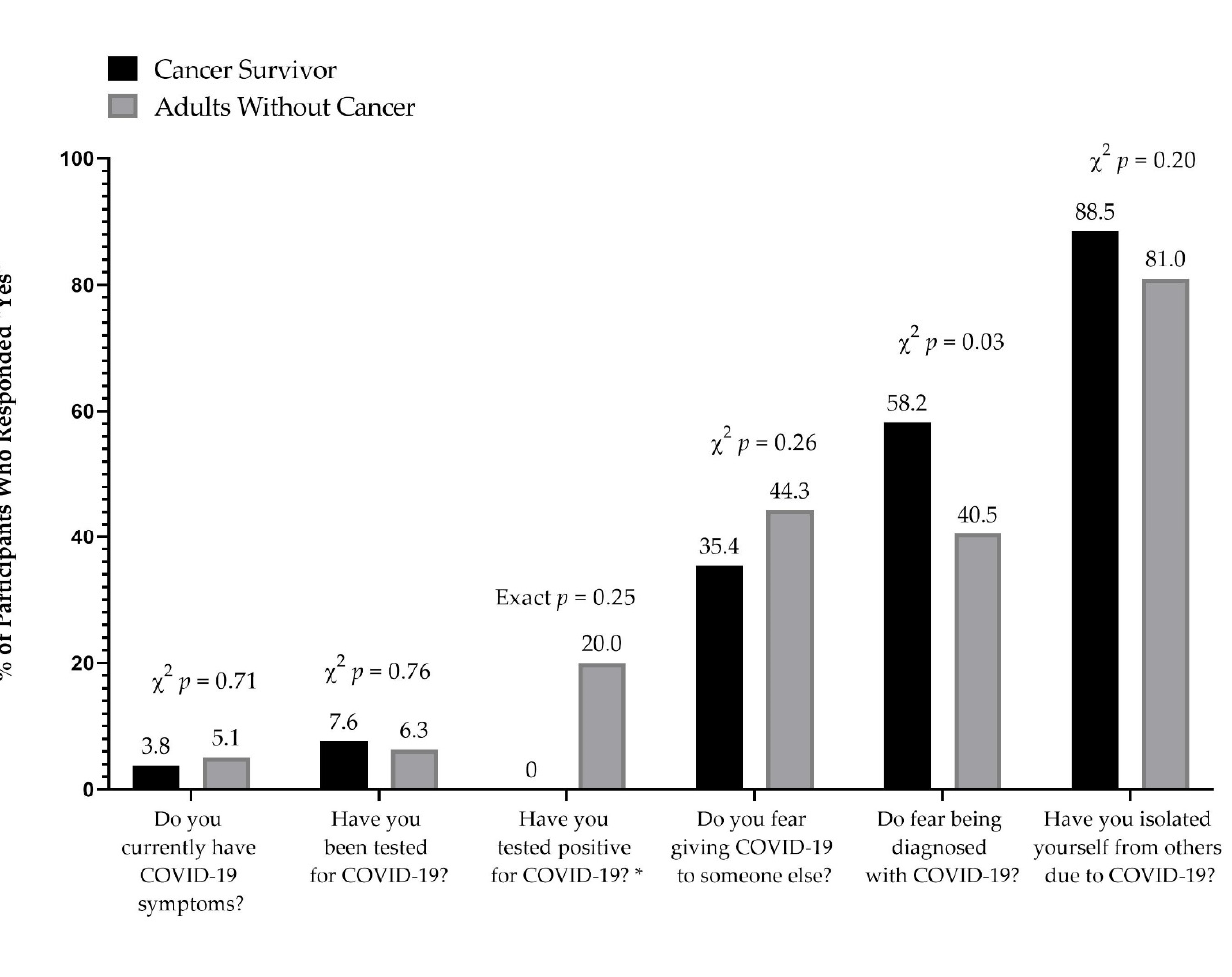
Figure 2. COVID-19-Related Concerns among the COVID-19 Cannabis Health Questionnaire respondents (21 March 2020–23 March 2021) among age-matched cancer survivors ( n = 158).